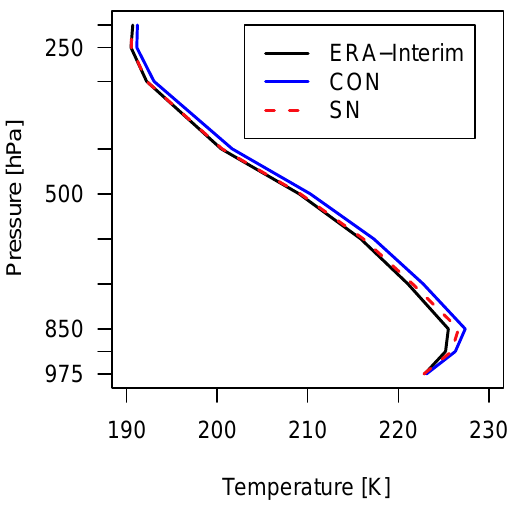
Fig. 7. Vertical temperature profiles for ERA-Interim (black), CON (blue) and SN (red) for the region north of 84 ◦ N.